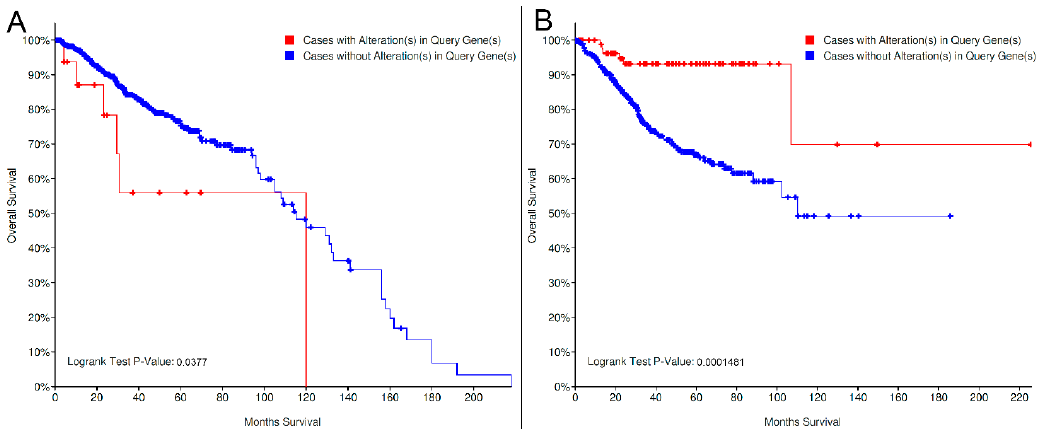
Figure 5. Overall survival of LRRK2 altered (MUT and/or CNV) vs. LRRK2 non-altered cases in prostatic adenocarcinoma ( A ) and endometrial carcinoma ( B ). The prognostic significance of LRRK2 altered cases is negative for prostatic cancer and positive for endometrial cancer [48–50]. MUT: point mutations, indels and fusions; CNV: copy-number variations.